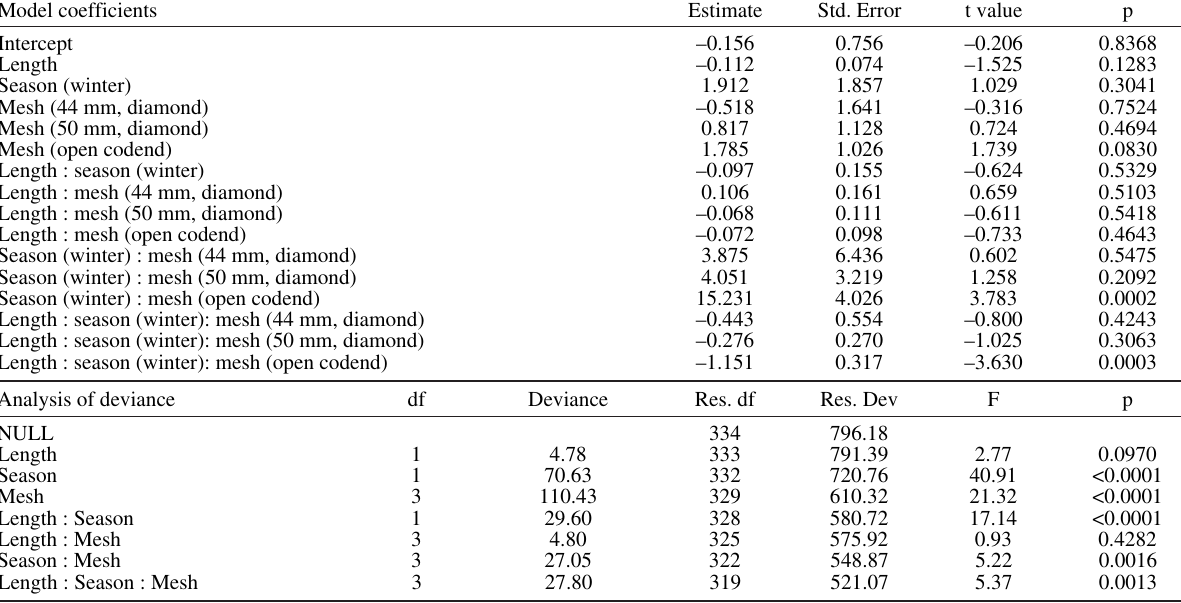
Table 4. – Results of GLM analysis of red mullet mortality in 2011. Note: as dispersion was estimated, parameter significance was assessed by an F